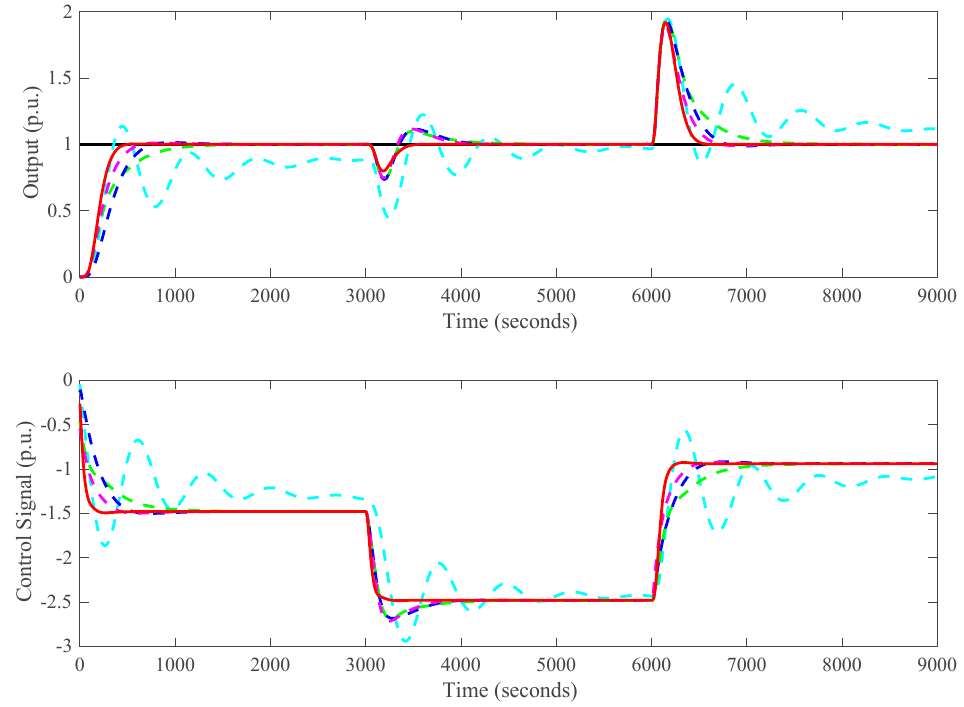
Figure 13. The simulation results of different control strategies. (Set point: — , OPI-PI: - - - , IPI-PI: - - - , ADRC-PI: - - - , MADRC-PI: - - - , Hybrid ADRC: — )